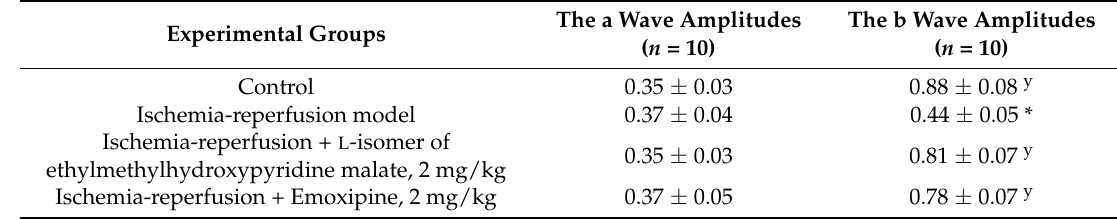
Table 1. Influence of L -isomer of ethylmethylhydroxypyridine malate and Emoxipine on the a and b wave amplitudes when correcting retinal ischemia-reperfusion (M ± m; n = 10), mV.